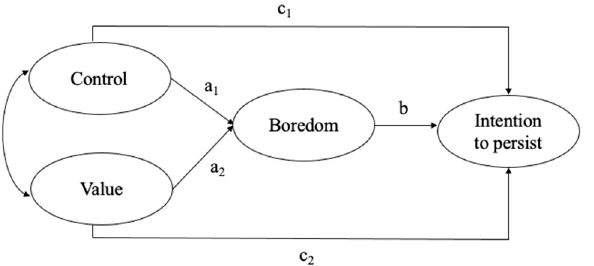
Figure 1. Hypothesized model. a1, link between control and boredom; a2, link between value and boredom; b, link between boredom and intention to persist; c1, link between control and intention to persist; c2, link between value and intention to persist.